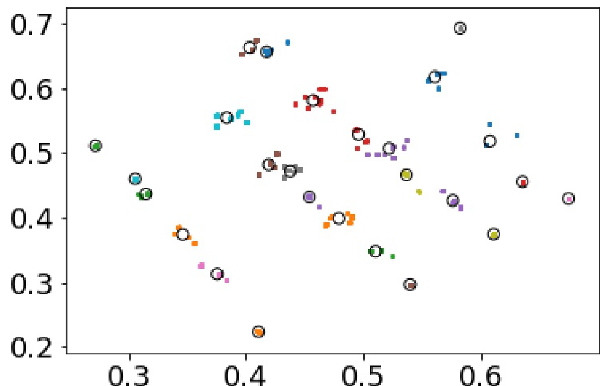
Figure 2 . Result of the autoencoder and k-means++ clustering, where the horizontal and vertical axes represent the (cid:12)rst and second components of ~x b , respectively. Circles correspond to centroids of colored clusters.